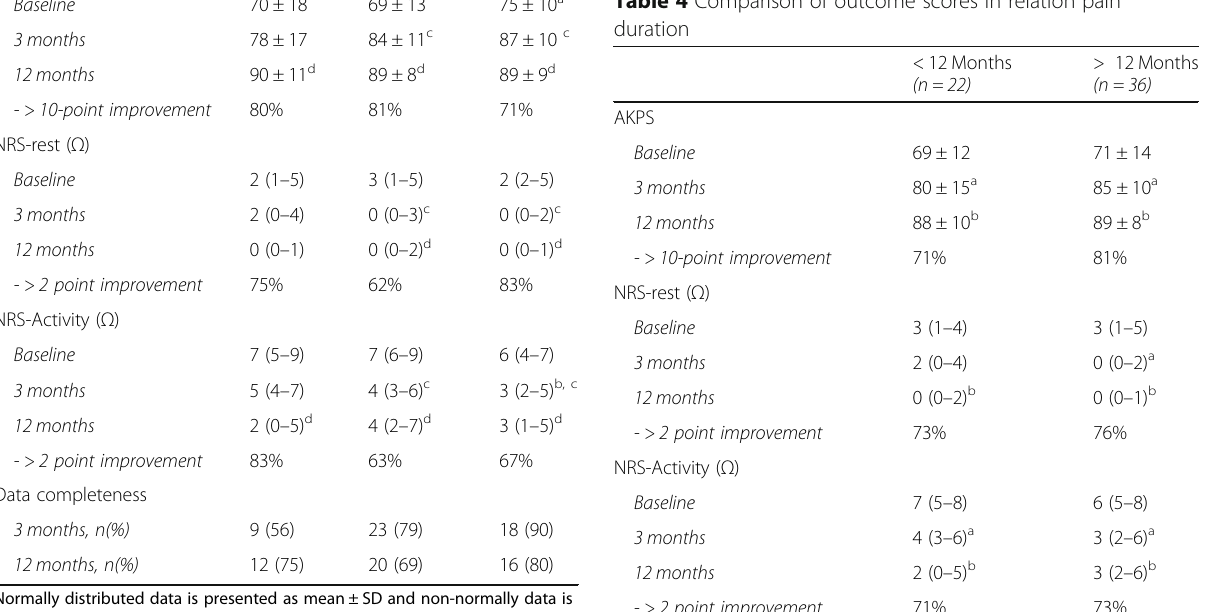
Table 4 Comparison of outcome scores in relation